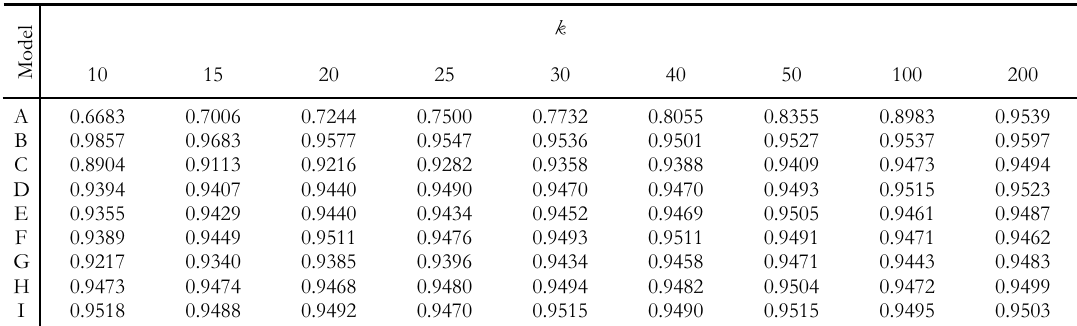
Percentages of correct inclusion